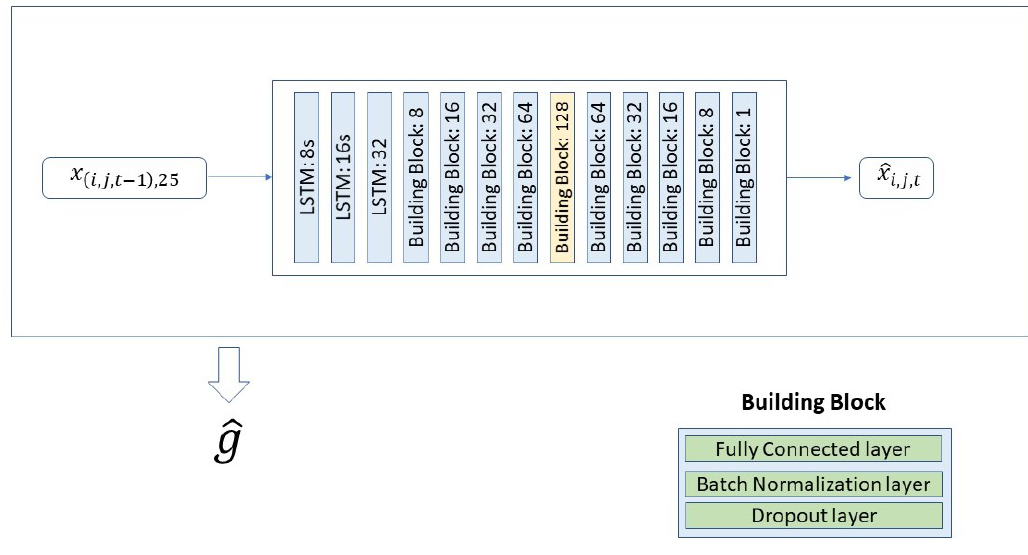
Figure 3. Neural Network structure of the transferred model. The notation LSTM: 8s represents a LSTM layer with 8 nodes and return sequence. The notation of Building Block:8 represents a building block with 8 nodes. The light yellow block represents the dropout layer with dropout rate